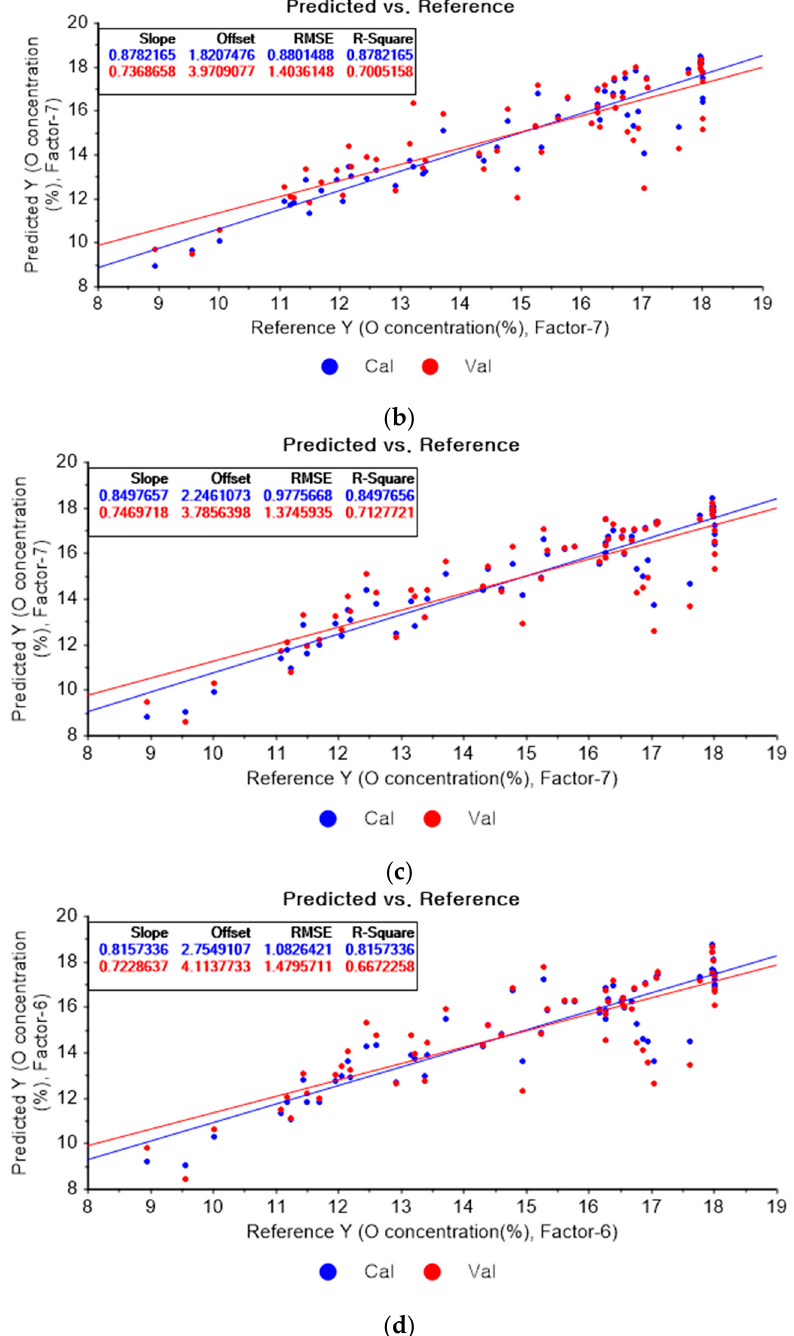
Figure 11. PLSR model of oxygen concentration with the ( a ) original data and PLSR models pre- processed by SG derivative using ( b ) third-order derivative and fifth-order polynomial with three points, ( c ) third-order derivative and fifth-order polynomial with five points, and ( d ) third-order derivative and fifth-order polynomial with seven points.